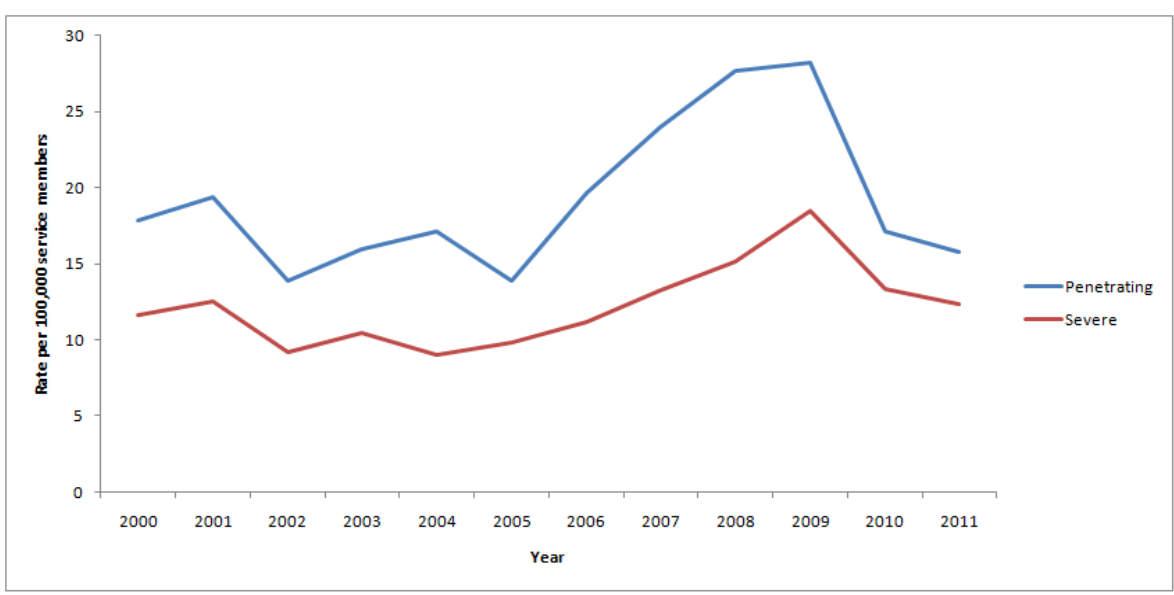
Figure 5. Estimated Annual Incidence Rates of Penetrating and Severe TBIs Among Active-Duty U.S. Military Service Members, 2000 – 2011